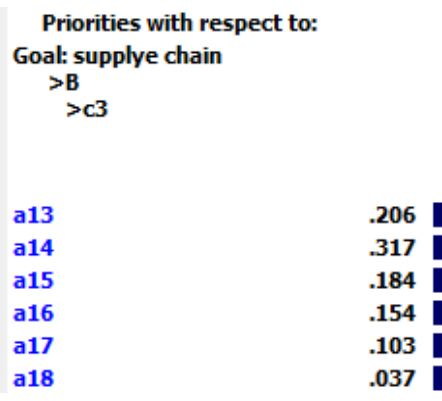
Fig. 6. Supplier ratings for category B components.